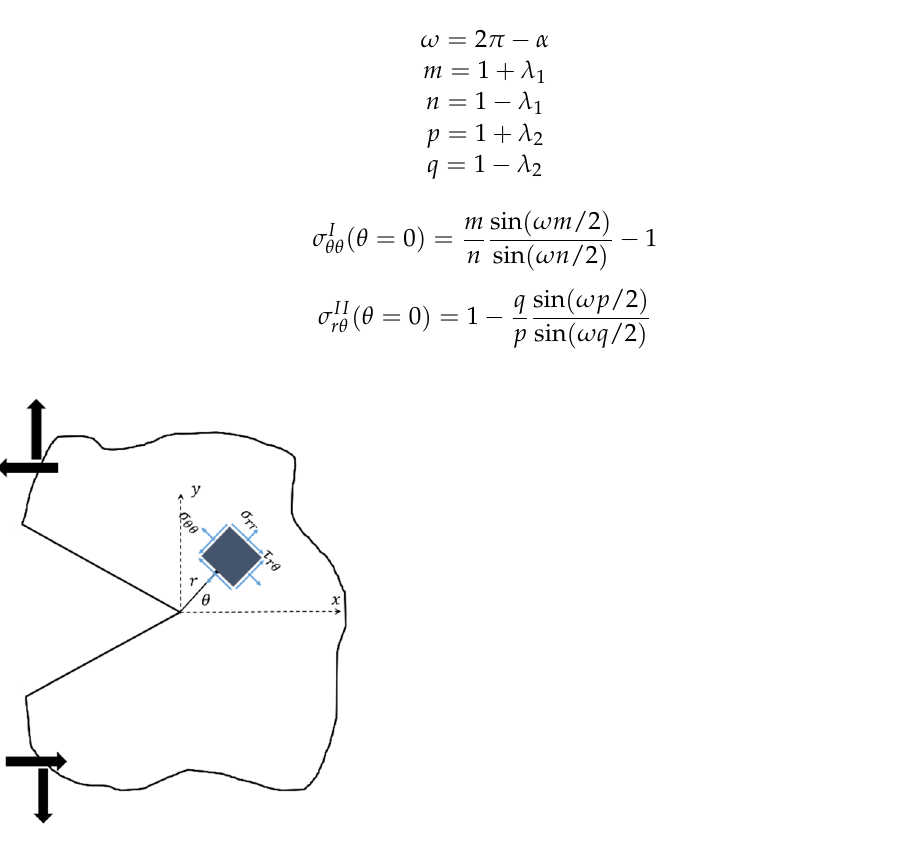
Figure 6. A sharp V-notch with its corresponding coordinates.